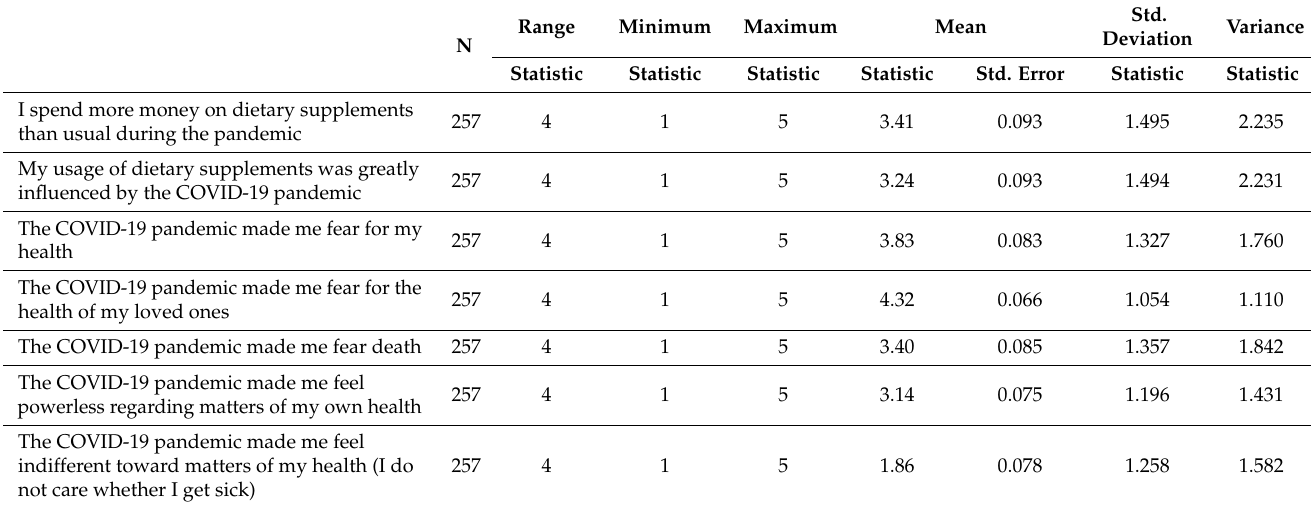
Table 3. Descriptive statistics for the chosen